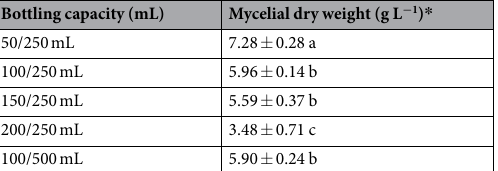
Table 1. Effect of bottling capacity on the mycelial growth of Isaria farinosa . * Mean ± SE. Values followed by the same letters within a column do not differ significantly (ANOVA, P = 0.05).